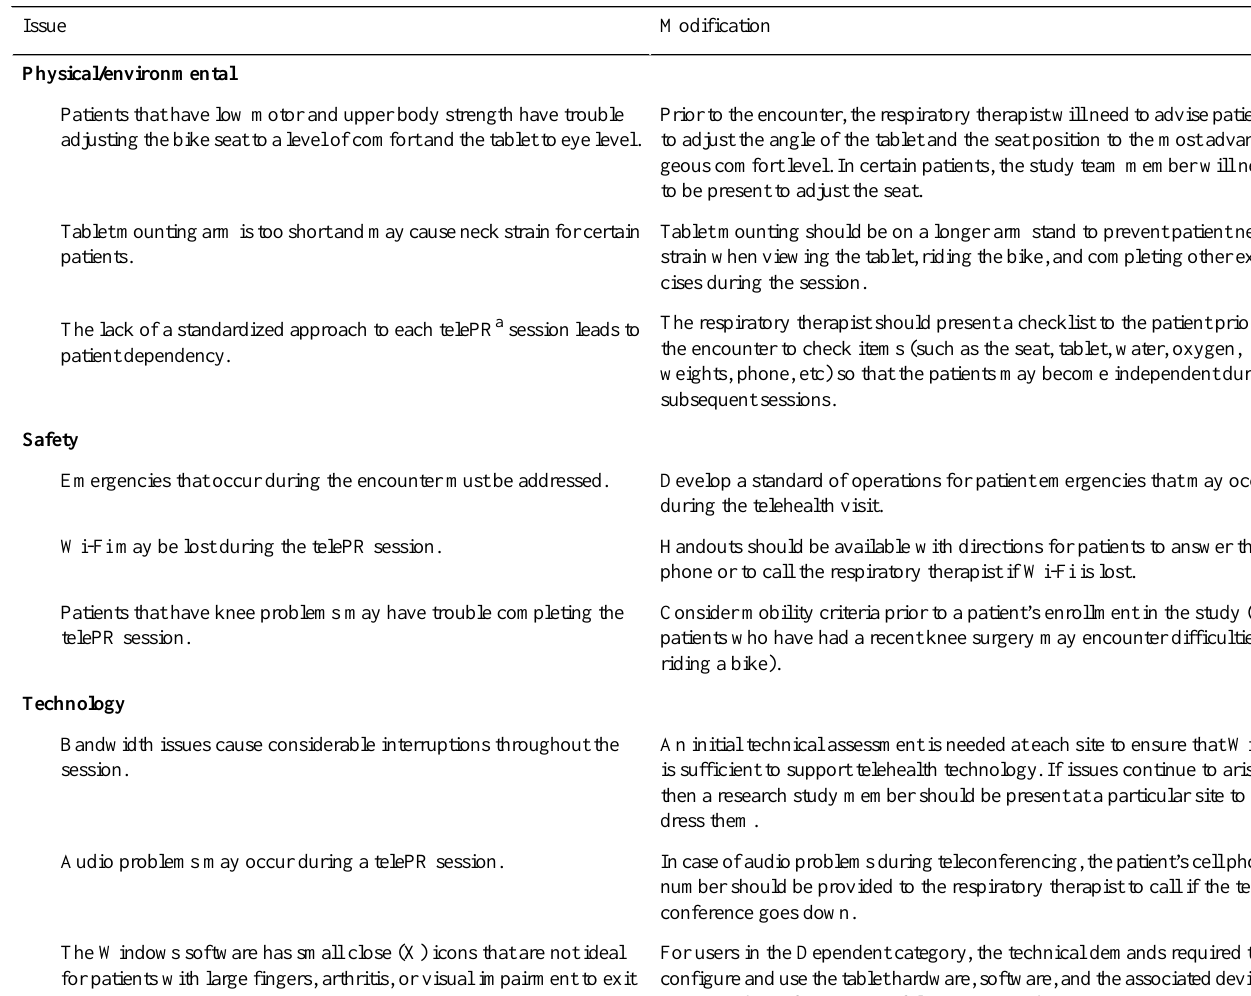
Table 2. Summary of system